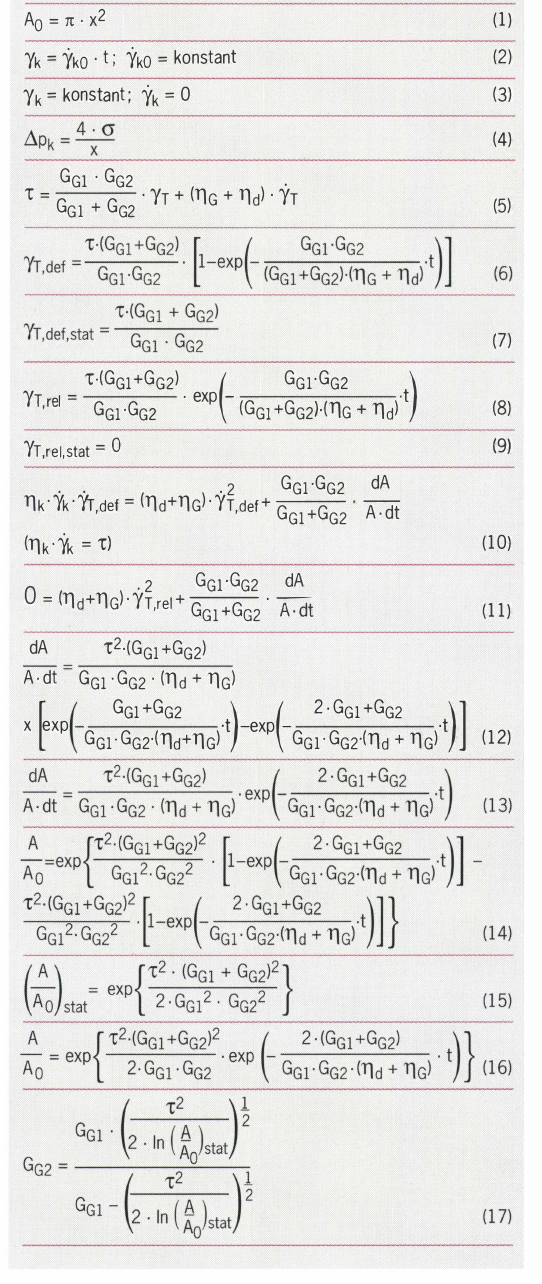
0 Fig. 7: Distribution of emulsifier molecules on the surface of a droplet B: stationar umstriimter Tropfen/ stationary droplet surrounded